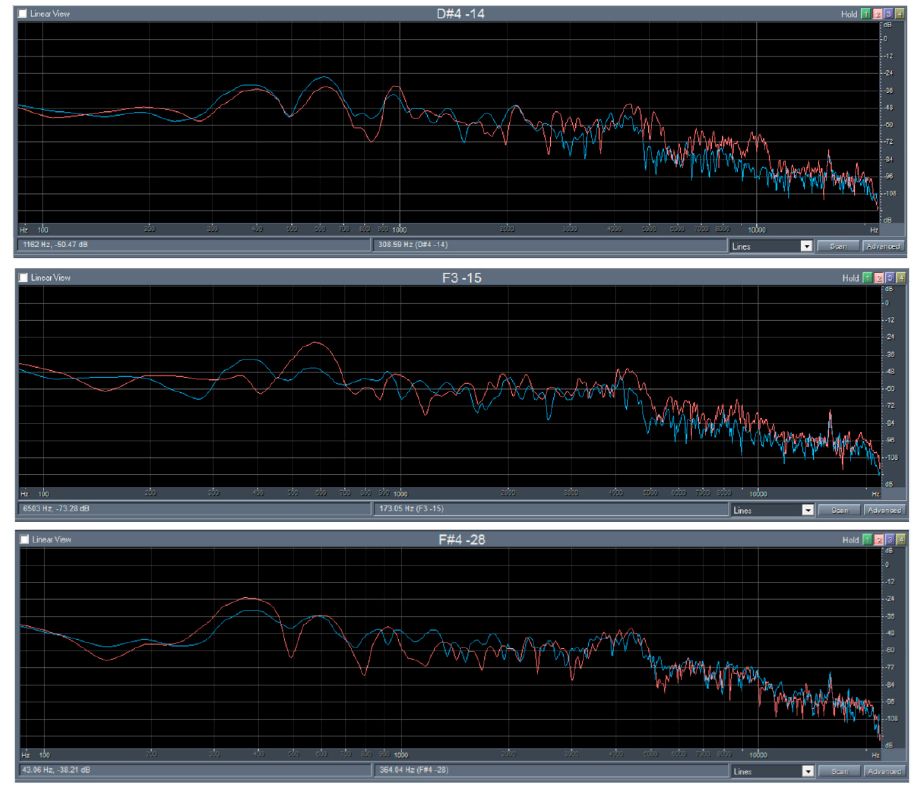
Figure 4. FFT analysis maple before and after thermal modification at 135 °C, 160 °C and 185 °C.